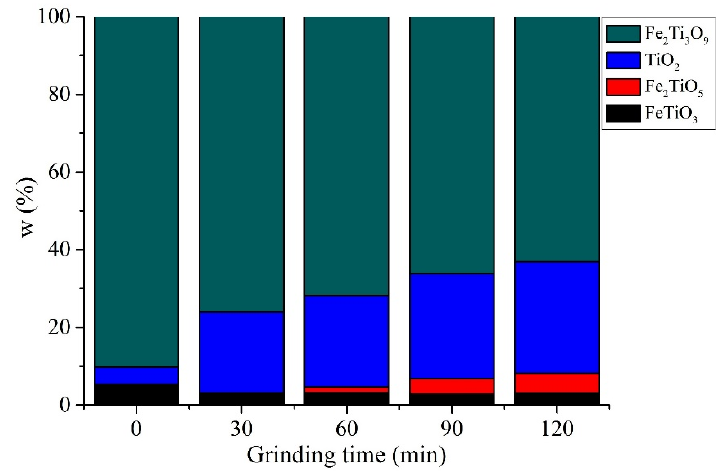
Figure 3. The mass percentage change of the main phase fraction of the ilmenite concentrate from the Malyshevske deposit, depending on the particle size after grinding for 2 h.